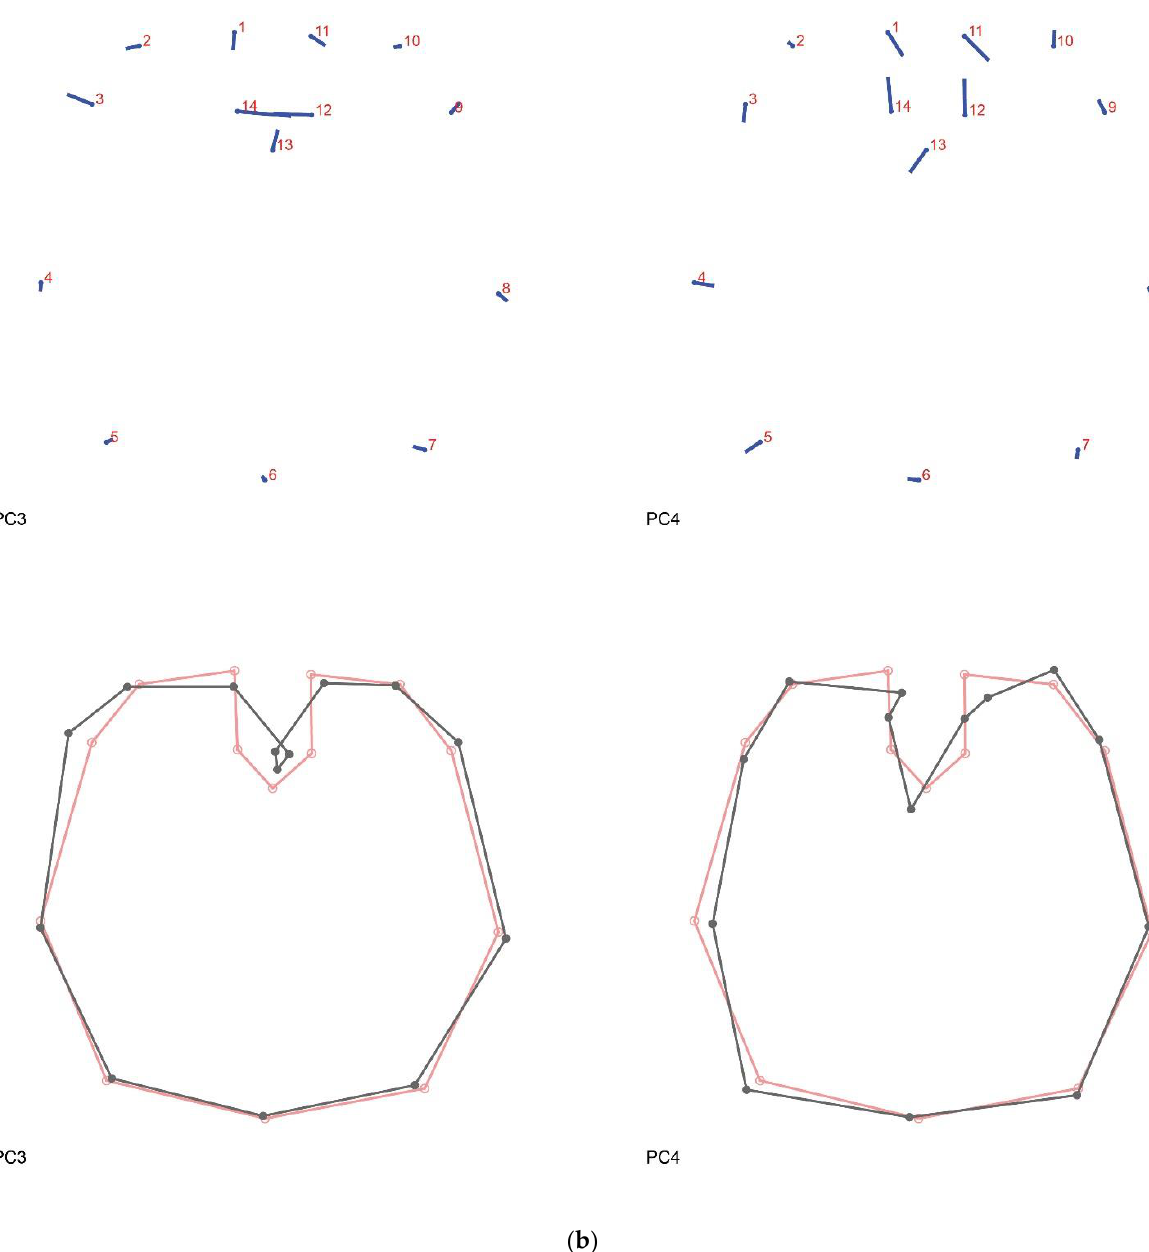
Figure A2. Principal component analysis shape changes. ( a ) PC1 (31.709%) and PC2 (26.582%); ( b ) PC3 (9.610%) and PC4 (7.106%). Lollipop graphs indicate the direction and magnitude of change per landmark associated with each PC. Wireframes indicate the mean shape (red) and the shape variation (dark grey).